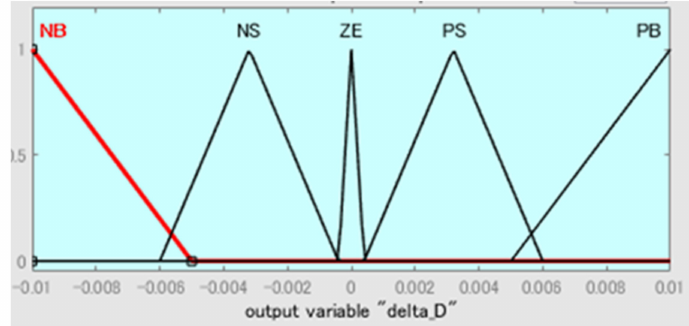
Figure 11. Output membership function for ∆ D [19].